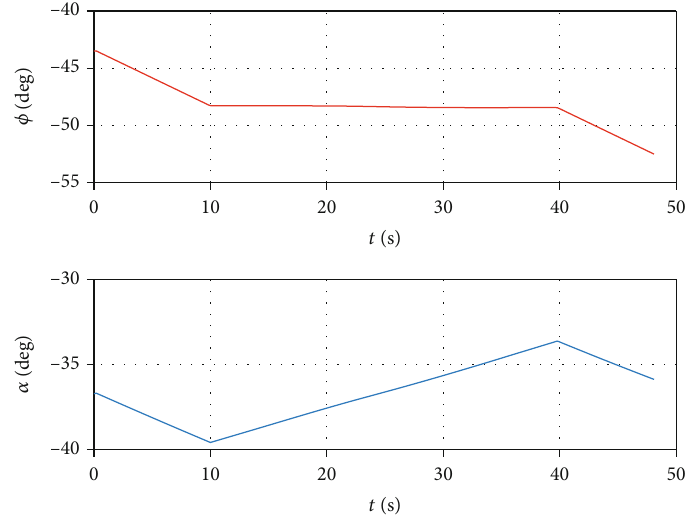
Figure 8: Time histories of the AOA and the pitch